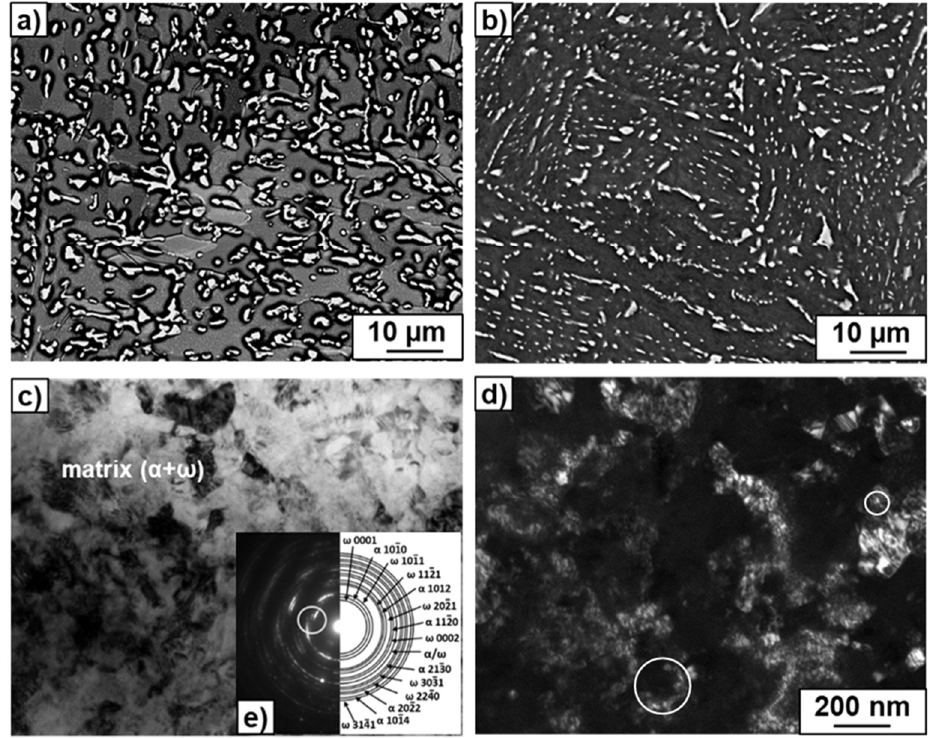
Figure 1. SEM micrographs for the Ti–4wt.%Co alloy preliminary annealed at 600 °C (2774 h) before high-pressure torsion (HPT) ( a ) and after HPT ( b ). Bright-field ( c ) and dark-field ( d ) TEM micrographs as well as the selected area diffraction pattern ( e ) for the (α + ω) matrix in Ti–4wt.% Co alloy preliminary annealed at 600 °C (2774 h) after HPT. The circle in Figure 1e marks the reflections used for the dark-field image in Figure 1d. The circles in Figure 1d mark the example grains of α- phase (dark grain, big circle) and ω-phase (bright grain, small circle).